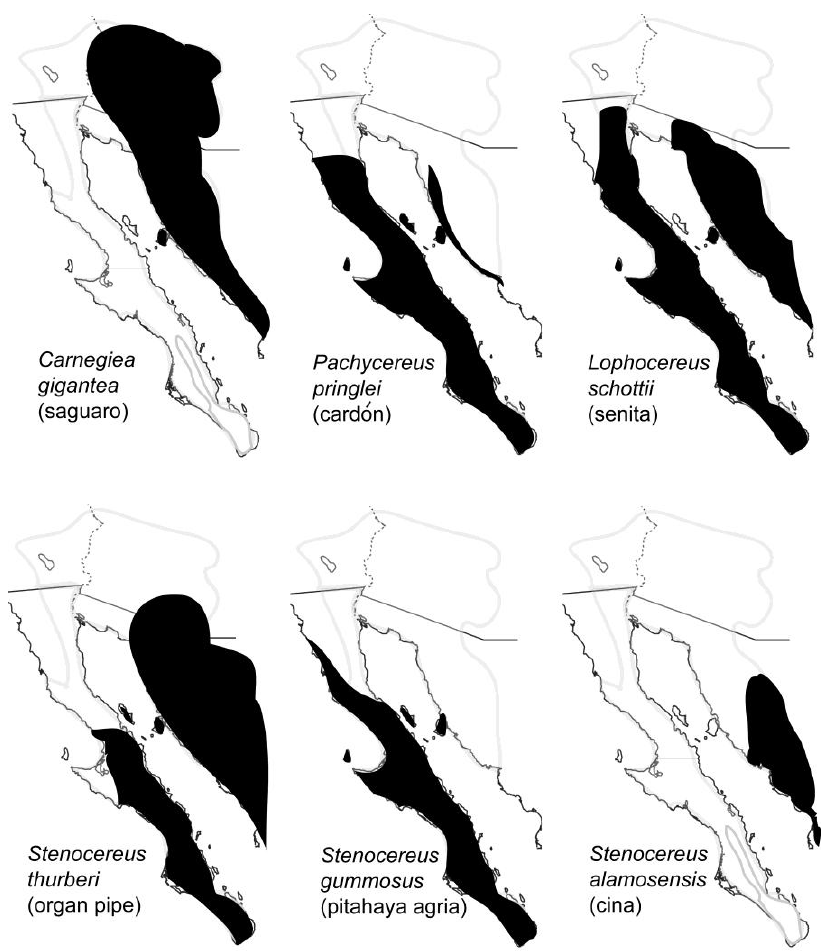
Figure 2. Approximate distributions of the principal cactus hosts (black shaded areas) utilized by the Sonoran Desert arthropods discussed herein based on data given